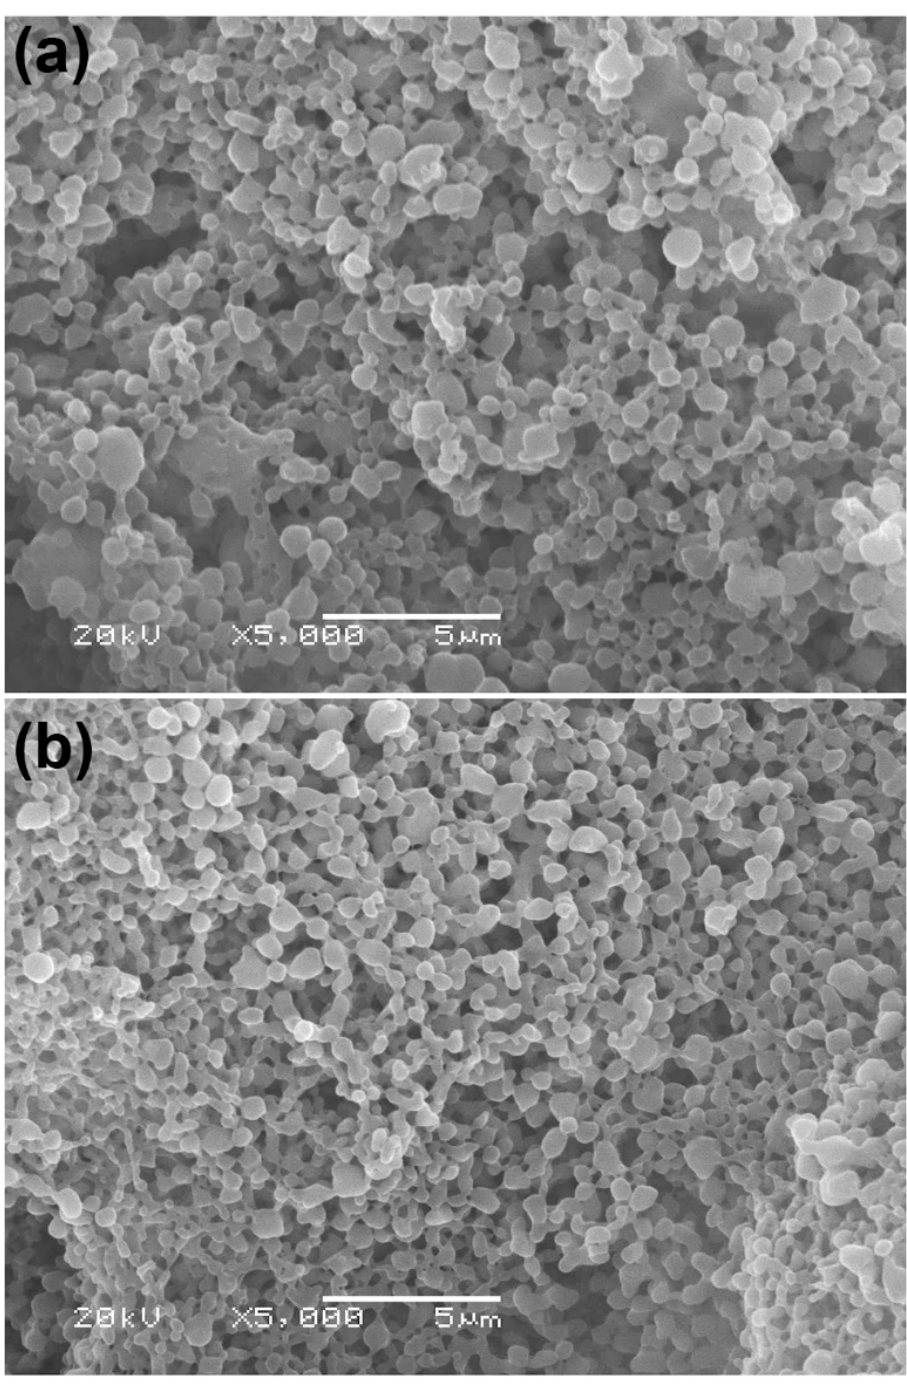
Figure 1. SEM images of ( a ) LMW-PLLA and ( b ) scPLA powders (All bar scales = 5 µm).